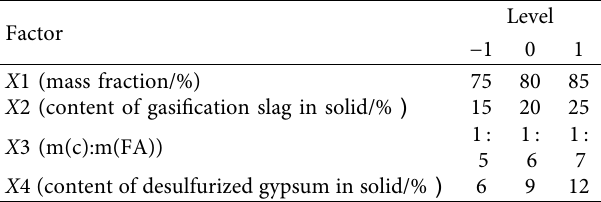
Table 1: Factors and levels in the design scheme of the central composite experiment.